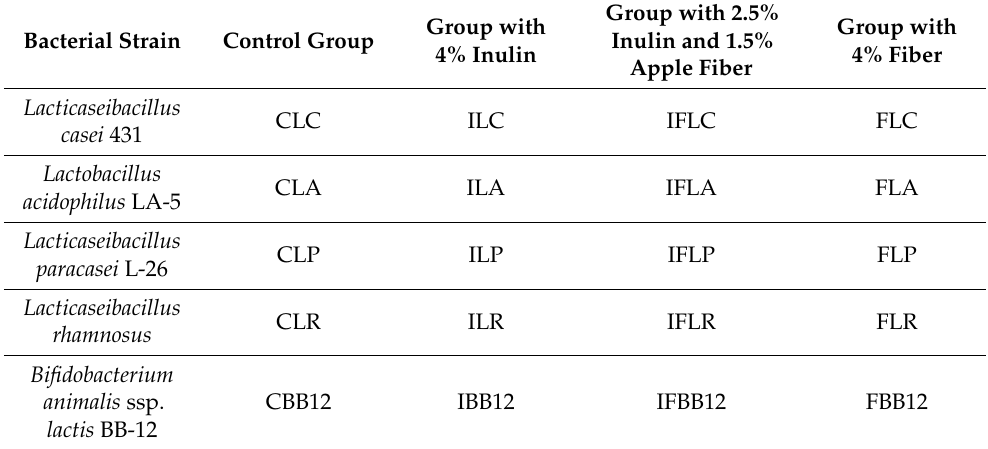
Table 1. Ice cream experimental